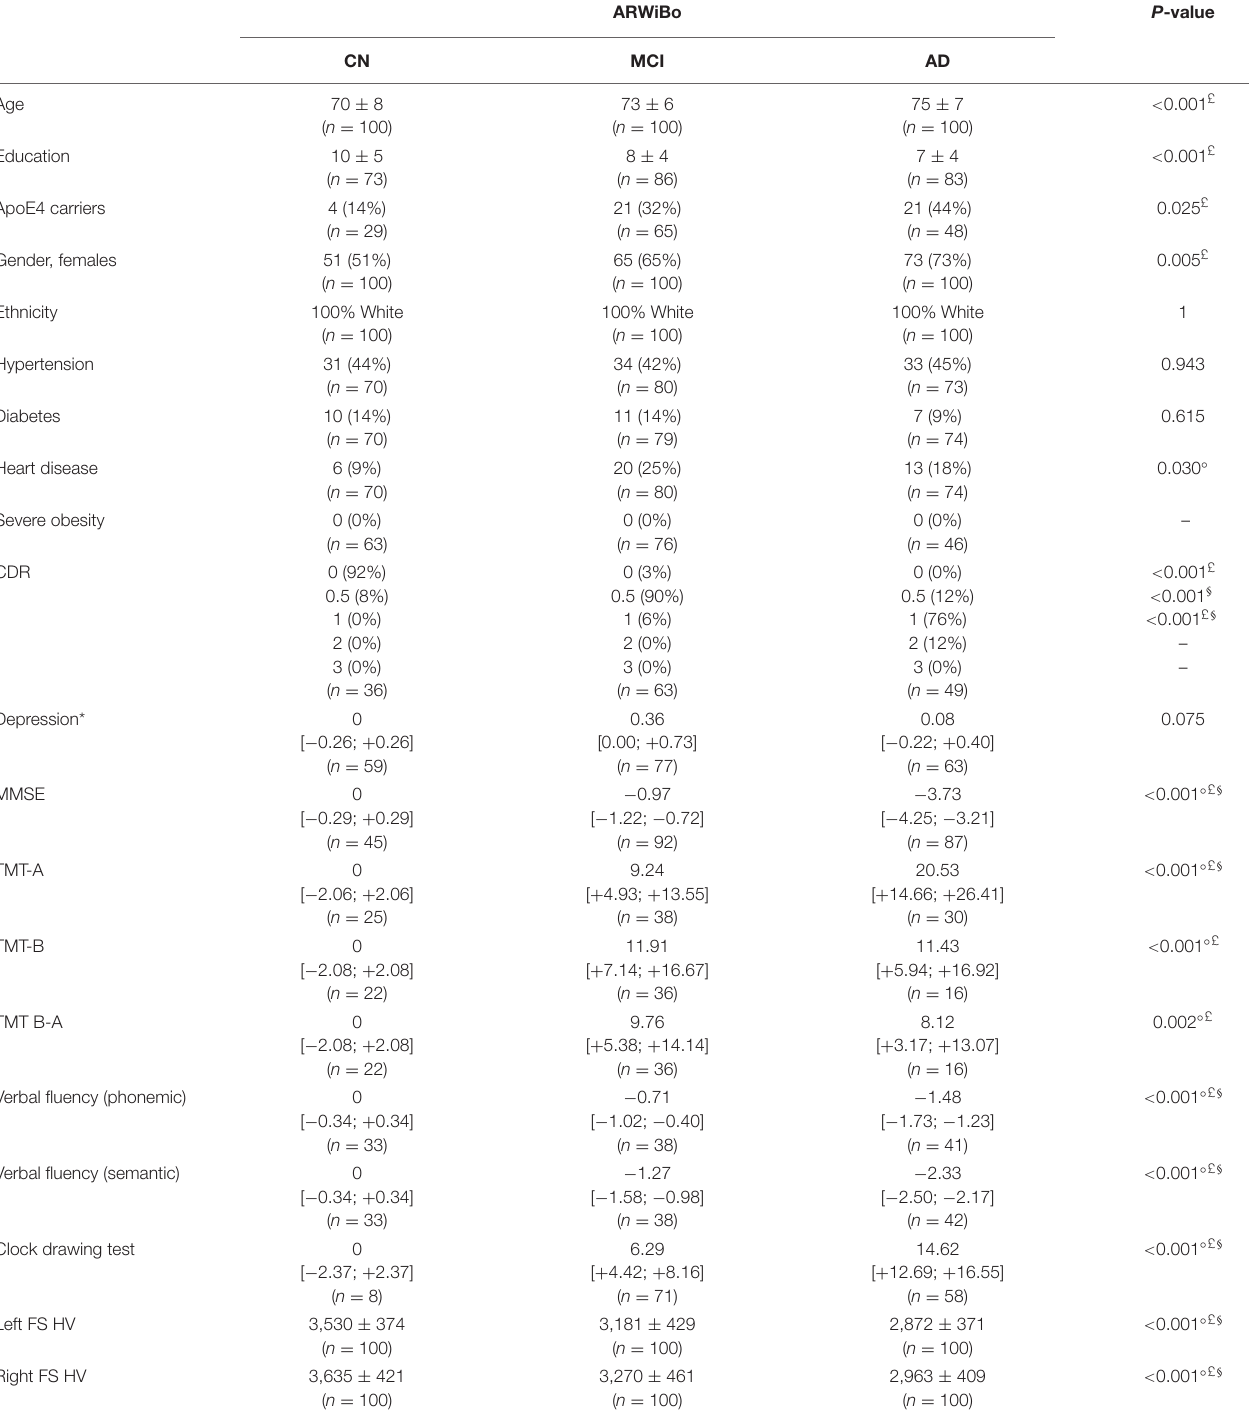
TABLE 4 | ARWiBo sociodemographic, clinical, neuropsychological, and morphological